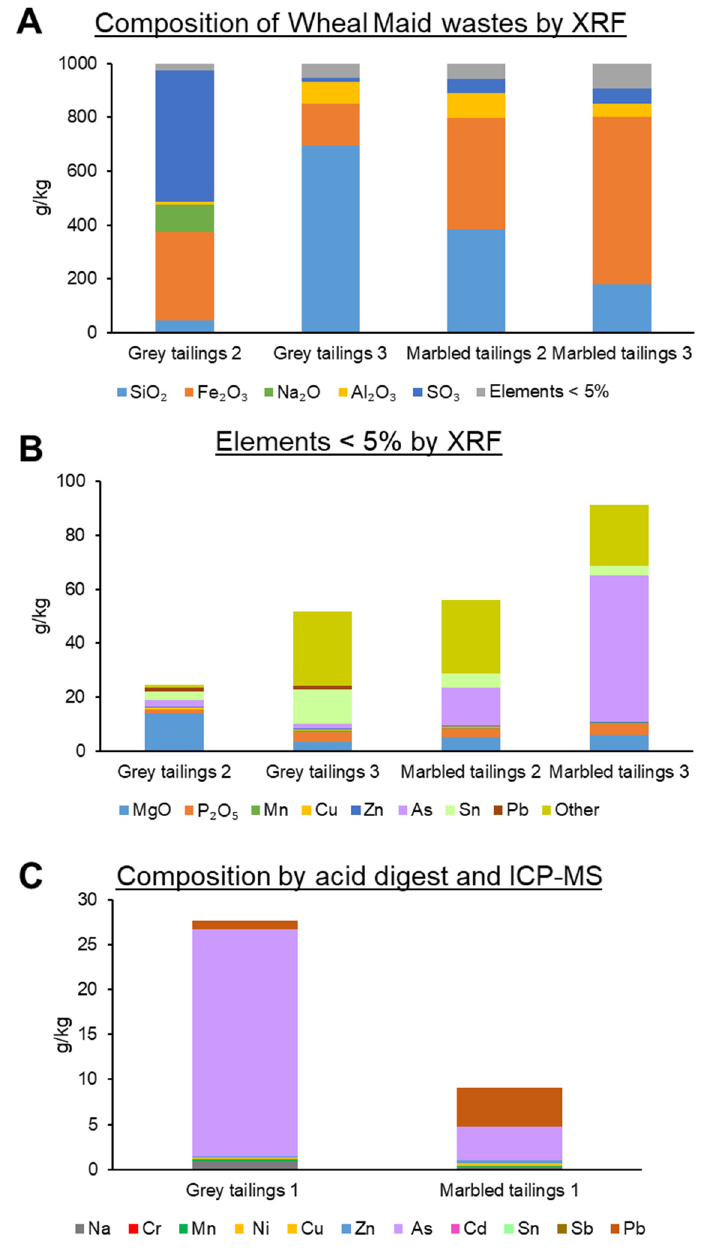
Figure 3. Bulk geochemistry of Grey and Marbled Tailings. ( A ) XRF results. ( B ) Elements < 5% by XRF. ( C ) Composition by acid digest and analysis by ICP-MS, values are the average of two replicates; results for Fe (323 g kg − 1 in Grey Tailings and 324 g kg − 1 in Marbled Tailings) are not shown for scale.